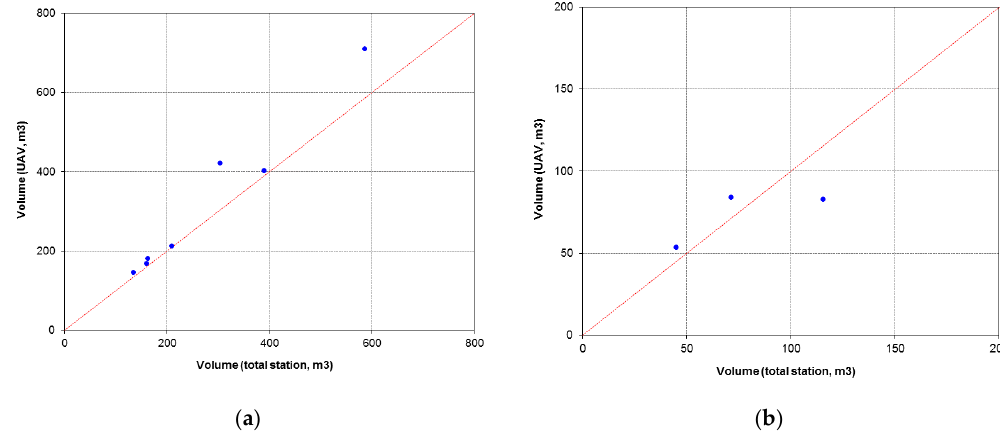
Figure 6. Scatter plots of sediment wedge volumes measured by the aerophotogrammetric and topographic methods for ten check dams (Sierra de Los Donceles forest, Castilla La Mancha, Spain) ( a ), larger check dams, V > 100 m 3 , ( b ), smaller check dams, V < 100 m 3 .